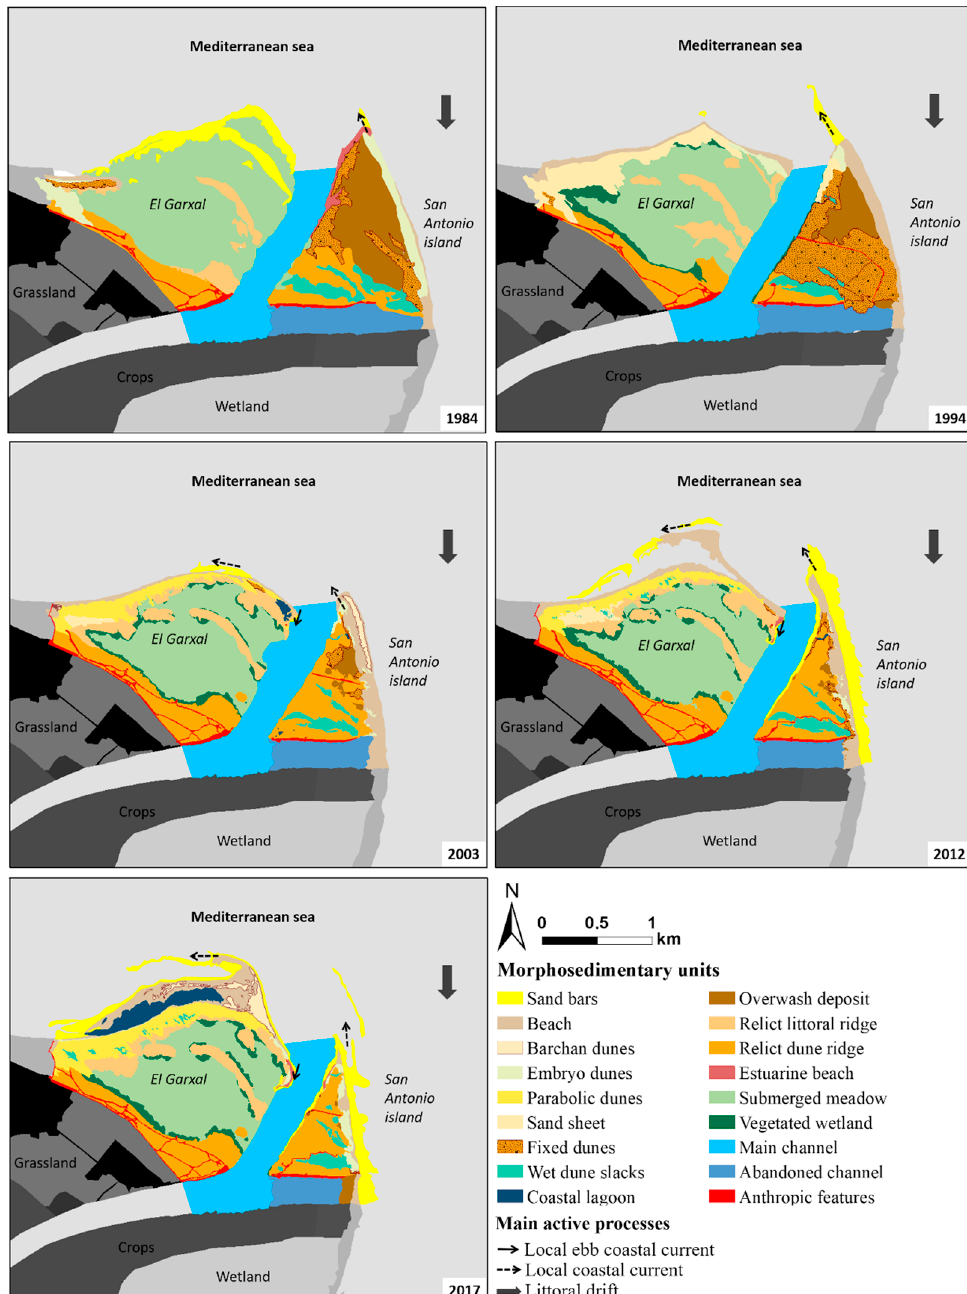
Figure 4. Historical evolution of the eco-geomorphological features identified in Ebro River Delta mouth (1984–2017).